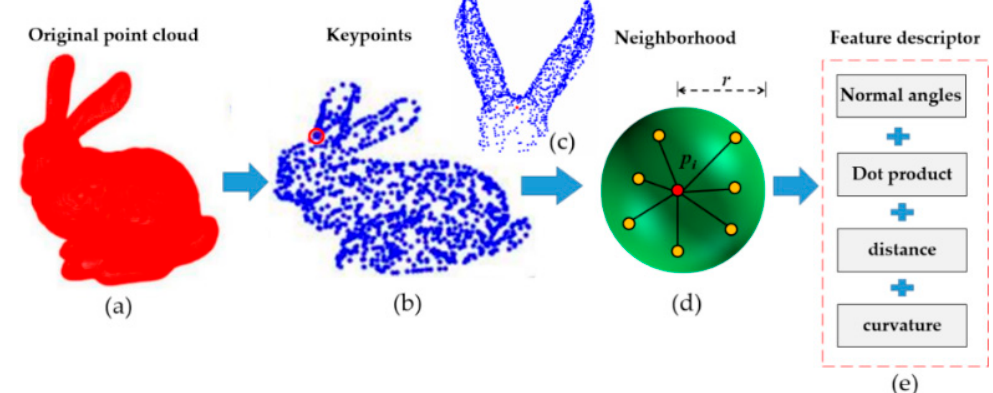
Figure 1. The schematic of the proposed descriptor. ( a ). The original point cloud. ( b ). Keypoints. ( c ). The enlarged detail of the red circle and its surrounding points in ( b ) image. ( d ). The neighboring points of a specified point. ( e ). Feature descriptor.